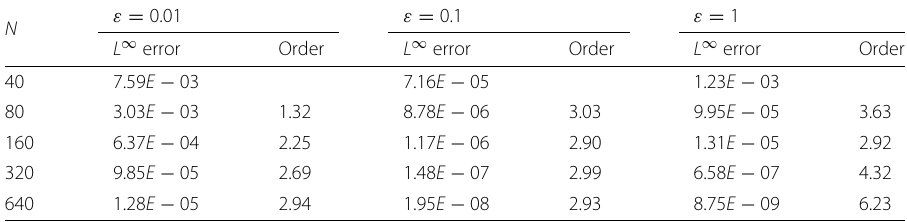
Table 1 Example 1. L ∞ errors and numerical orders of temporal accuracy obtained with the GSA IMEX-ARS3 WCNS at t = 0.1